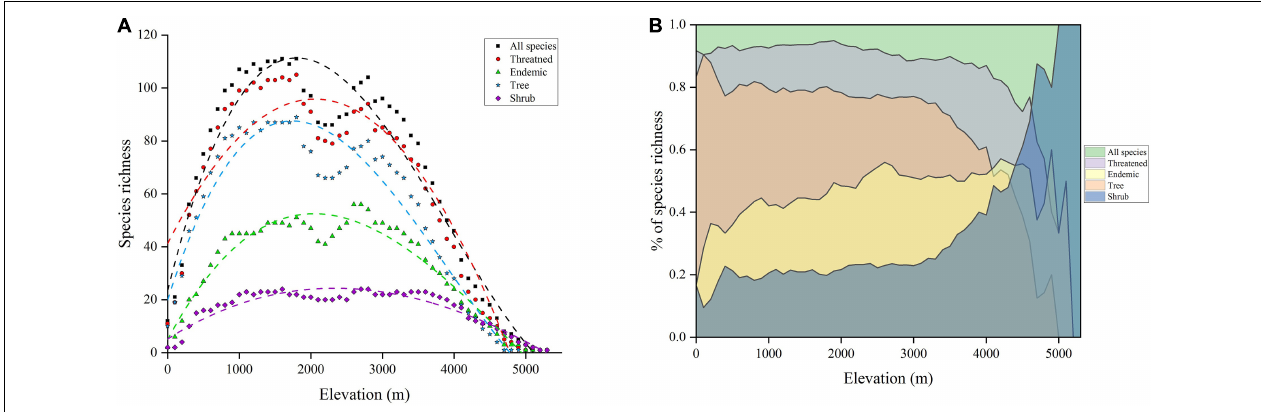
FIGURE 2 | (A) Elevational pattern of species richness of gymnosperms in China. The dash lines indicate the best fit model of polynomial regression. (B) The proportion of different subgroups concerning total gymnosperm